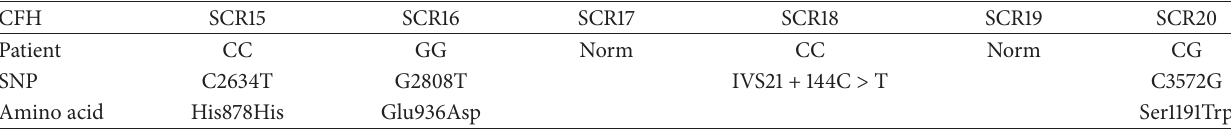
Table 2: Genetic analysis of Factor H